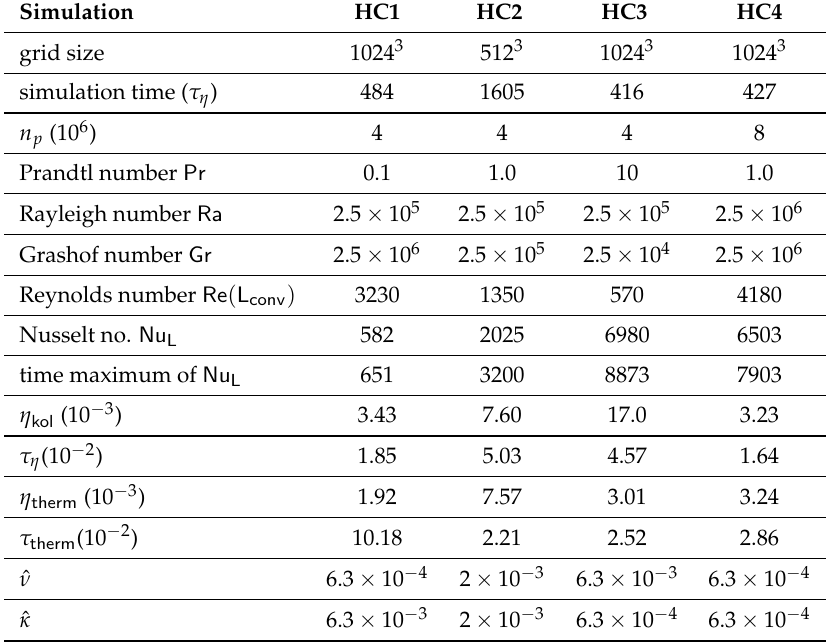
Table 1. Parameters of homogeneous hydrodynamic convection simulations. The simulations are defined by the value of the Rayleigh number, calculated according to Section 2.2, and the Prandtl number. The Nusselt number is calculated according to Equation (7). The Grashof number is defined Gr = Ra / Pr . The nondimensionalized kinematic viscosity ˆ ν and the thermal diffusivity ˆ κ are also